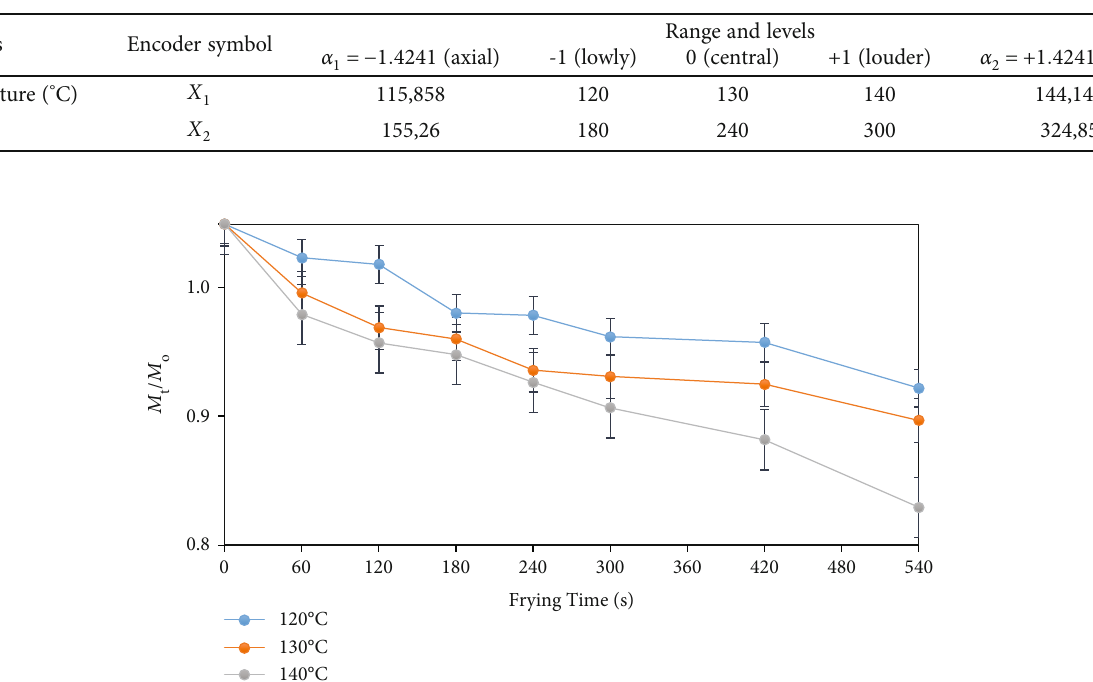
Figure 1: Kinetics of the loss of moisture of the Coastal Carimañolas at di ff erent frying times and